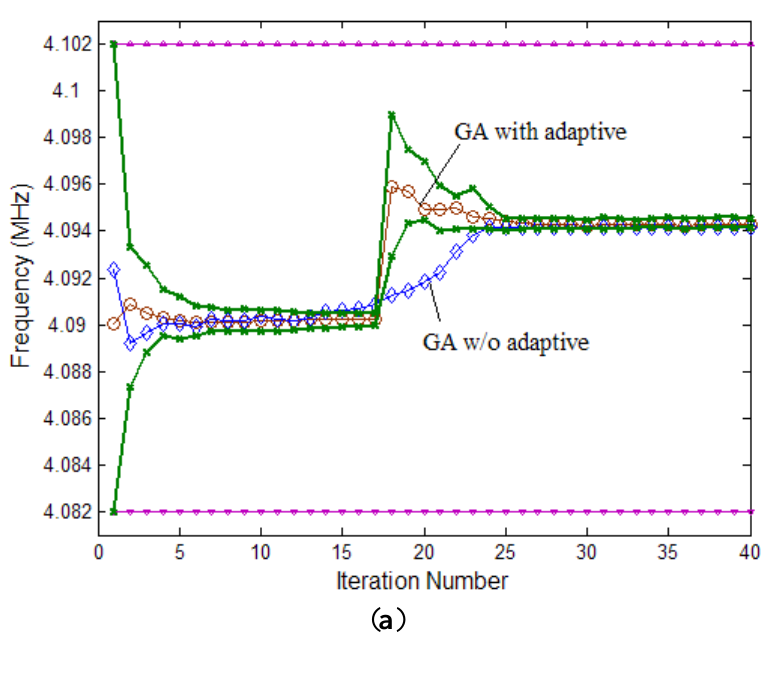
Figure 6. Signal search results; ( a ) Doppler frequency evolution versus iterations (PRN-8); ( b ) Code delay evolution versus iterations